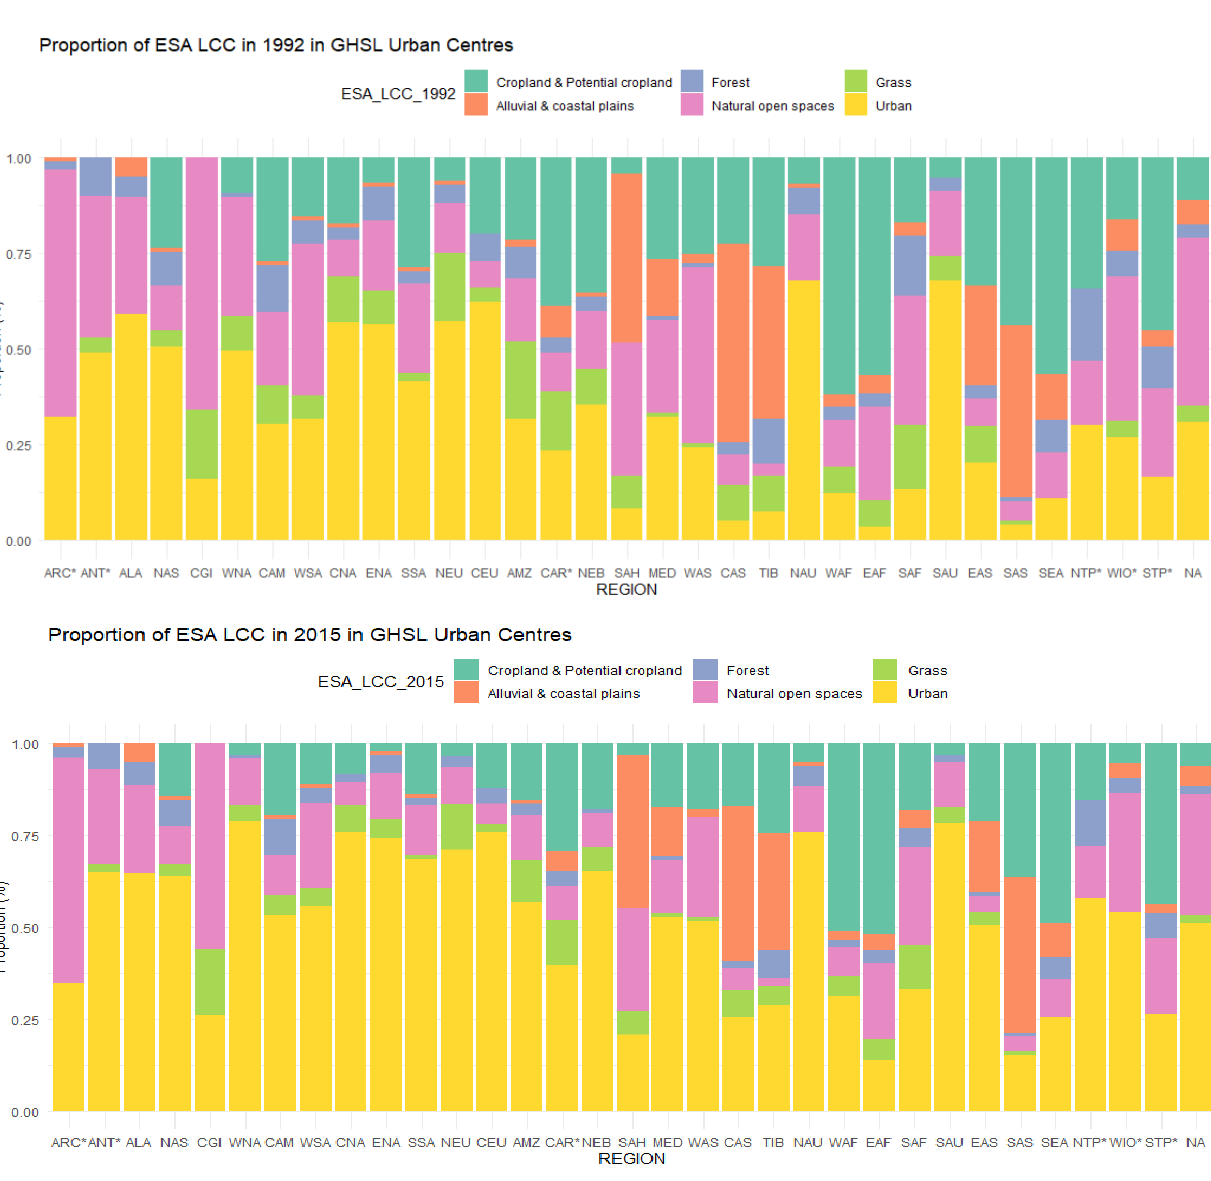
Figure 5. Landcover changes in urban centers.